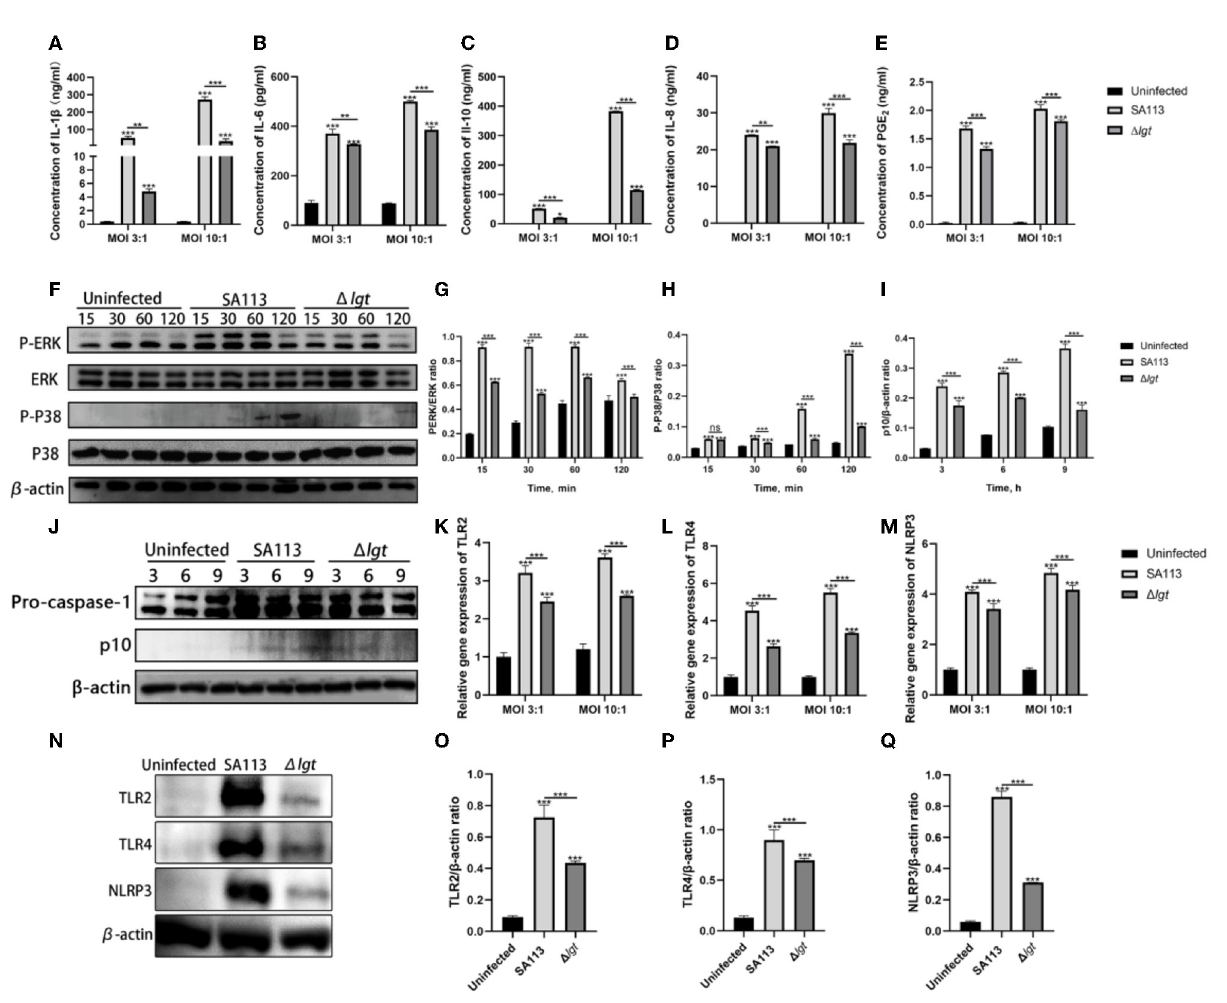
FIGURE1 Staphylococcus aureus lipoprotein is an important protein that can induce the secretion of PGE 2 and cytokines by neutrophils in dairy cows and can also activate TLR2, TLR4, and NLRP3 receptors and their mediated MAPK and Caspase-1 signaling pathways. ELISA results showed the secretion levels of cytokines IL-1 β (A) , IL-6 (B) , IL-10 (C) , IL-8 (D) , and PGE 2 (E) in the uninfected, SA113, and 1 lgt groups after neutrophil infection with MOI 3:1 and MOI 10:1. Western blot analysis revealed the activation of the MAPK (F–H) and Caspase-1 (I, J) signaling pathways. TLR2, TLR4, and NLRP3 receptor genes (K–M) and protein (N–Q) expressions were detected by qRT-PCR and Western blot. ns P > 0.05, * P < 0.05; ** P < 0.01; *** P < 0.001.